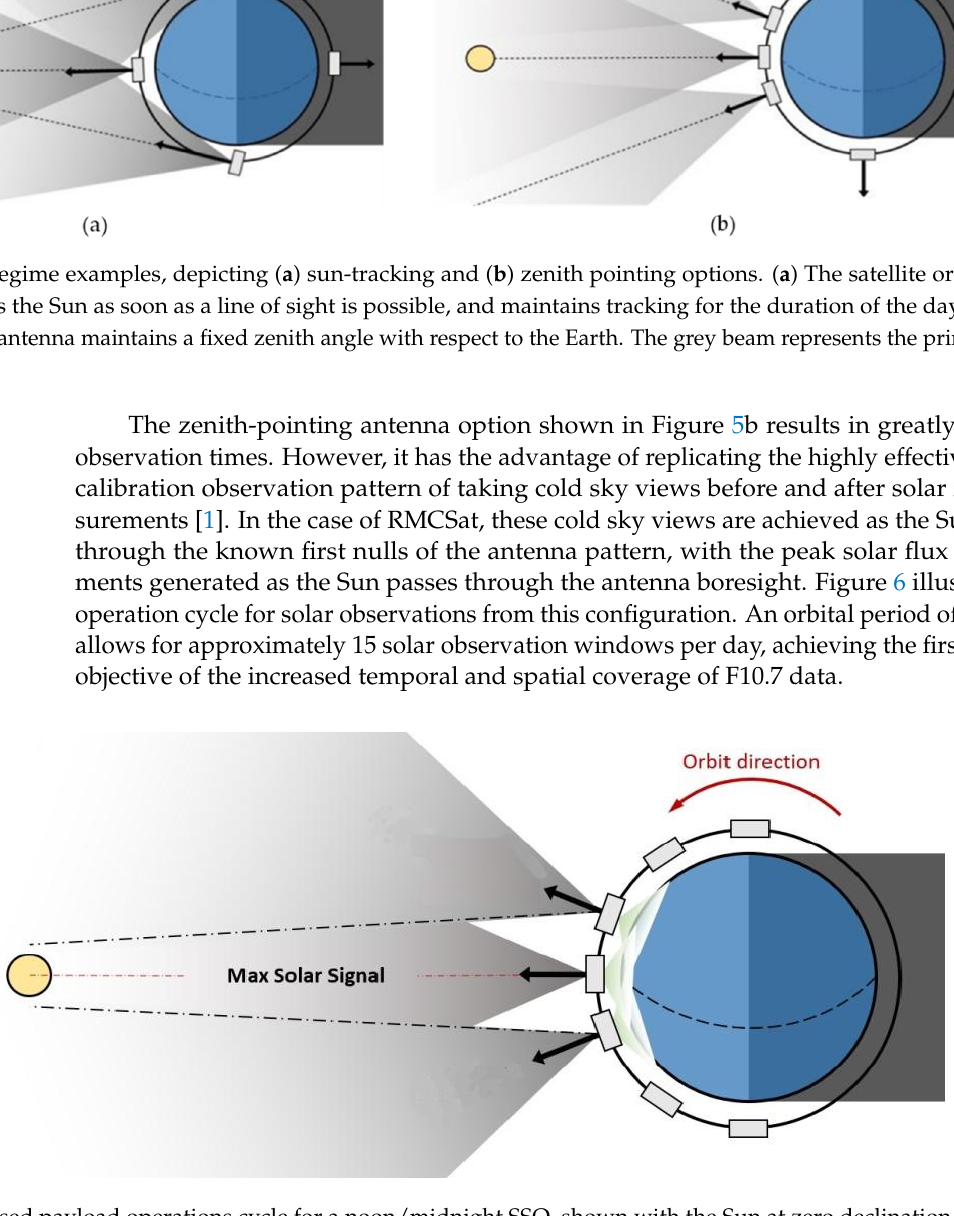
Figure 6. The proposed payload operations cycle for a noon/midnight SSO, shown with the Sun at zero declination. The grey zenith-pointing beam is the primary payload antenna, the green lower beam represents the secondary antenna for Earth flux sensing. The timing of measurement operations ensures that the Sun passes through the first null of the antenna beam at the beginning and end of each measurement. This example depicts a local noon descending node, however, the direction of noon equatorial crossing is not important for data collection operations.